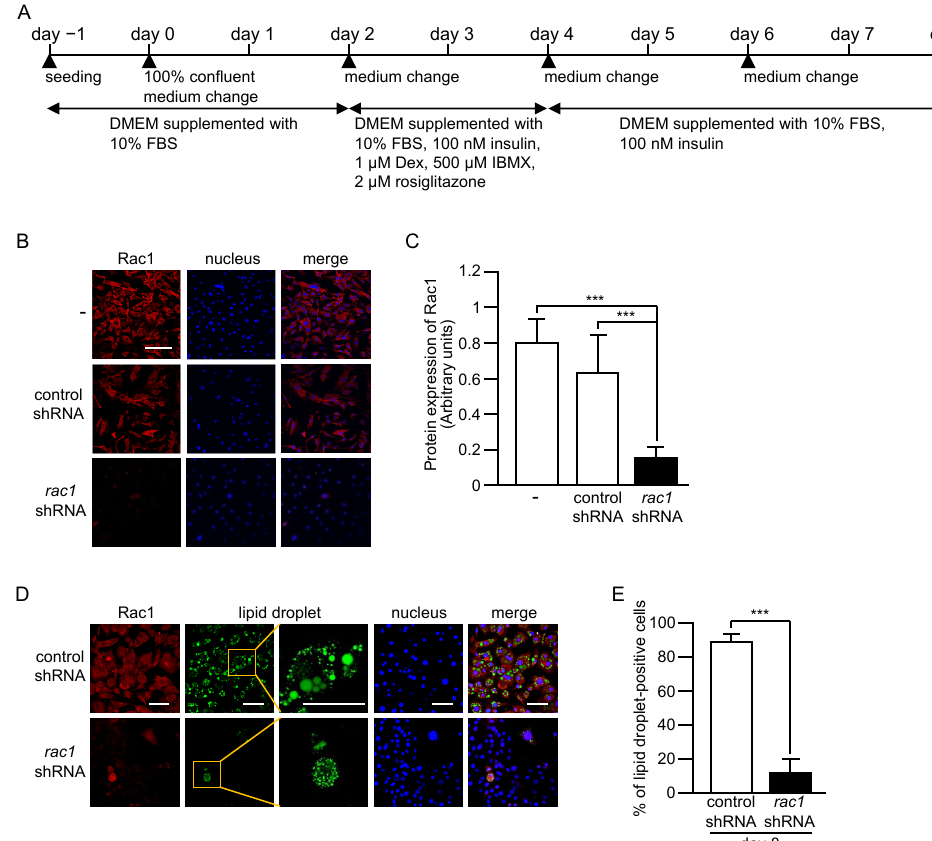
Figure 7. Differentiation of 3T3-L1 cells into adipocytes in vitro. ( A ) Schematic representation of the differentiation protocol. The day when cells reached confluence was referred to as day 0. ( B ) sh-RNA- mediated knockdown of Rac1 in 3T3-L1 cells. The protein expression level of Rac1 in 3T3-L1 cells that expressed control or Rac1-targeting shRNA was determined by immunofluorescent microscopy. Nuclei were stained with 4 (cid:48) ,6-diamidino-2-phenylindole. Scale bar, 200 µ m. ( C ) Fluorescent staining of Rac1 as shown in ( B ) was quantified. Data are shown as means ± S.E. ( n = 36). *** p < 0.001 (Student’s t test). ( D ) Fluorescent staining of Rac1 and lipid droplets with an anti-Rac1 antibody and LipiDye, respectively, in differentiated 3T3-L1 adipocytes that expressed control or Rac1-targeting shRNA at day 8. Nuclei were stained with 4 (cid:48) ,6-diamidino-2-phenylindole. For the staining of lipid droplets, the high-magnification image (right) of the boxed area in the low magnification image (left) is also shown. Scale bar, 100 µ m. ( E ) The percentage of lipid droplet-containing cells in differentiated 3T3-L1 adipocytes that expressed control or Rac1-targeting shRNA at day 8 was calculated. Data are shown as means ± S.E. ( n = 36). *** p < 0.001 (Student’s t